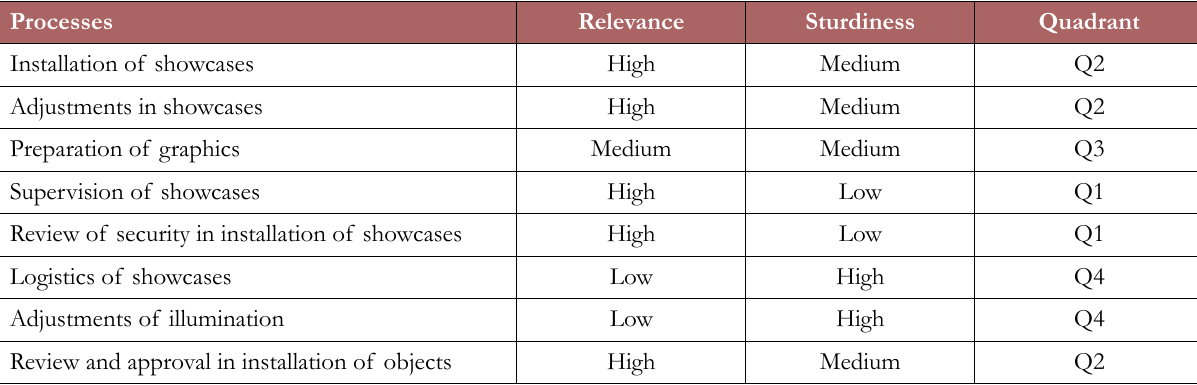
Table 5. Assessment of the candidate for